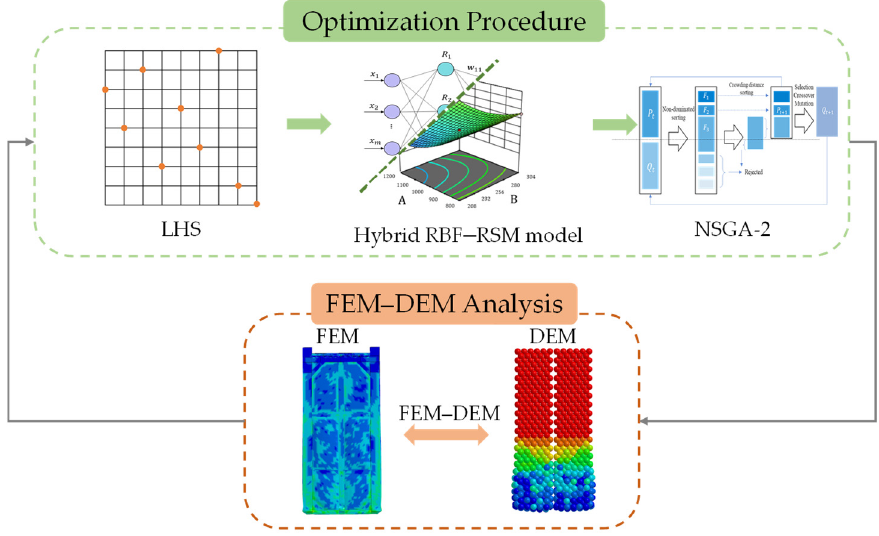
Figure 1. Optimization procedure for SFE canister.